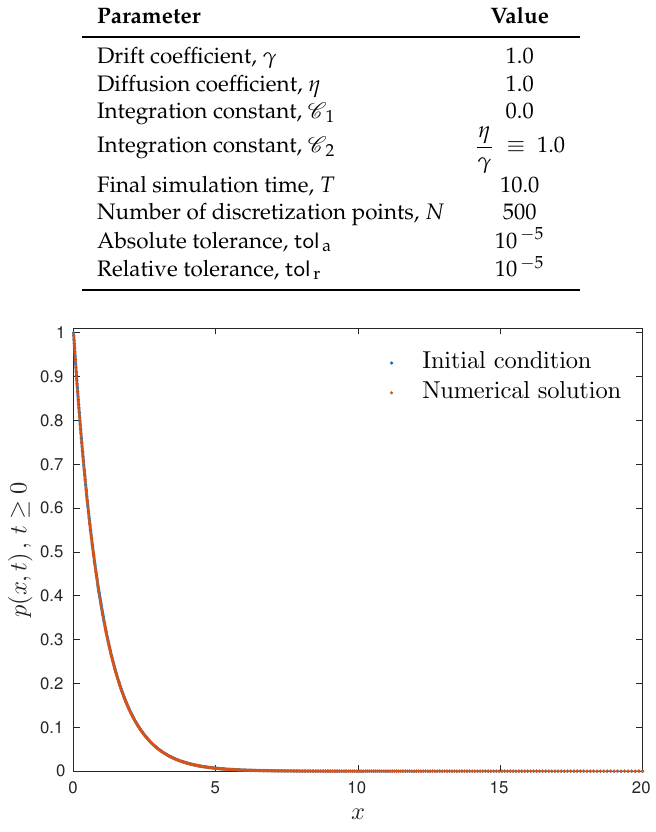
Figure 1. Comparison of a steady state solution of class (2) at t = 0 and at t = T = 10. They are indistinguishable up to the graphical resolution, which validates the